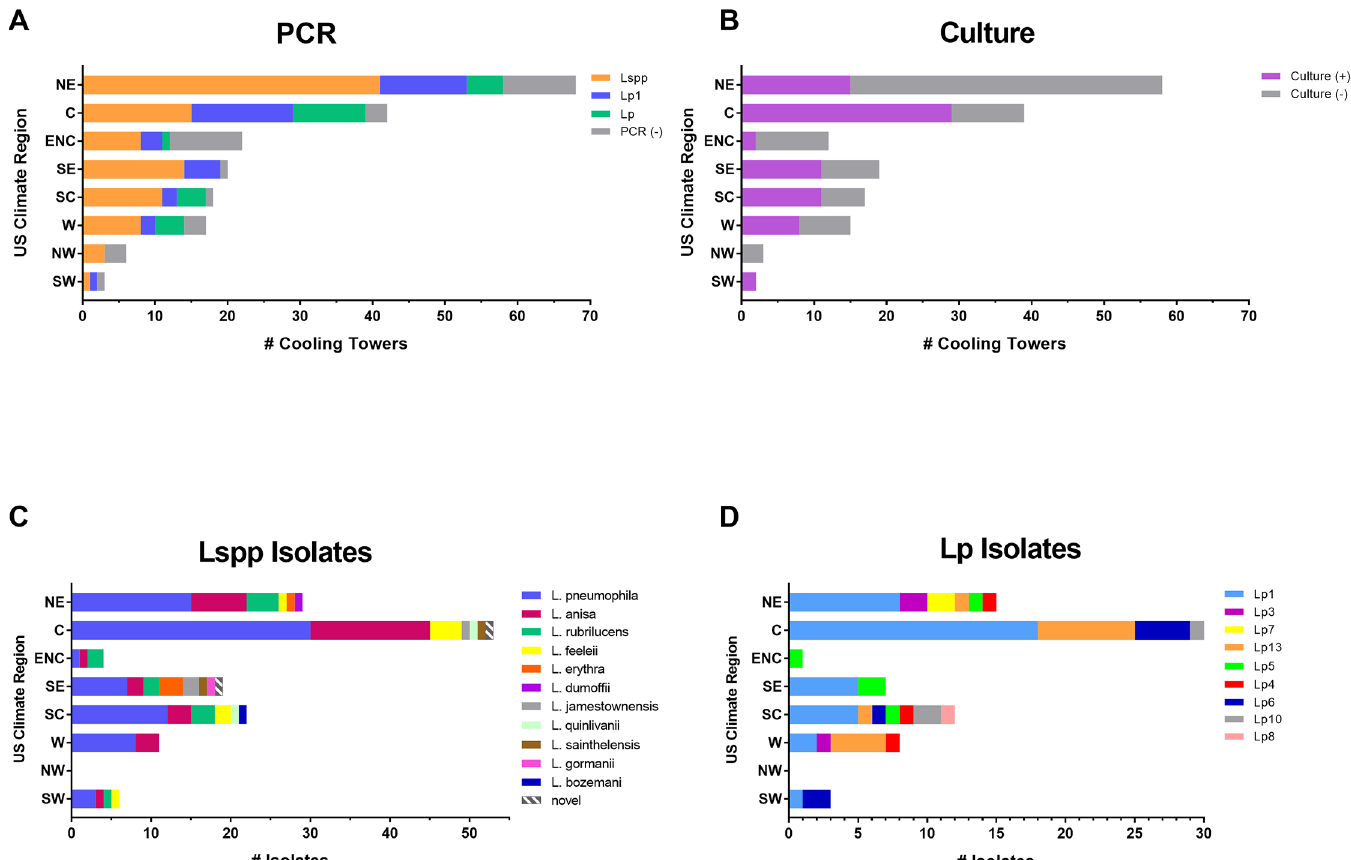
Fig 2. Geographic distribution of results. Samplesfrom eight US climate regions [Central (C), East North Central(ENC), Northeast (NE), Northwest (NW), South [Central] (SC), Southeast (SE), Southwest (SW), and West (W)] were assayed by PCR (A) and culture (B). Specimens that were positive for any of the targets by PCR underwent culture. Isolates were identifiedto the species (C) and L . pneumophila serogroup(D) level.